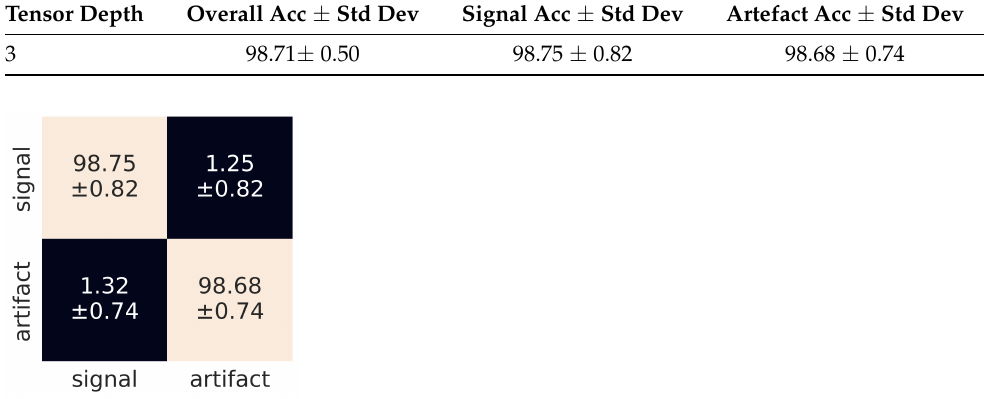
Figure 9. Confusion matrix for the raw data. The horizontal and vertical dimensions refer to predicted and judged labels,